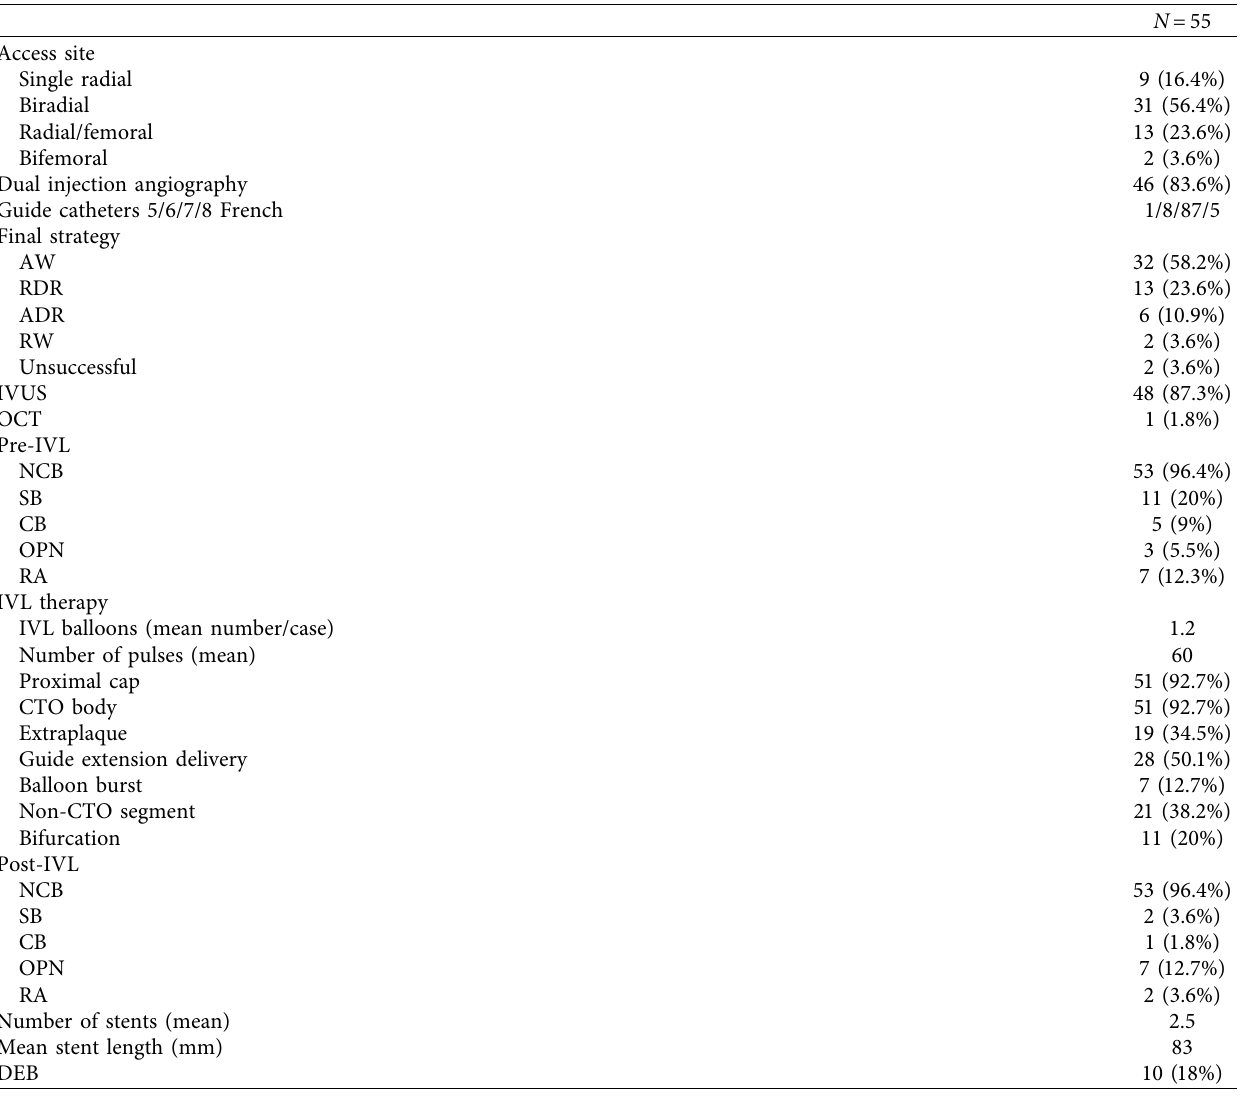
Table 2: Procedural